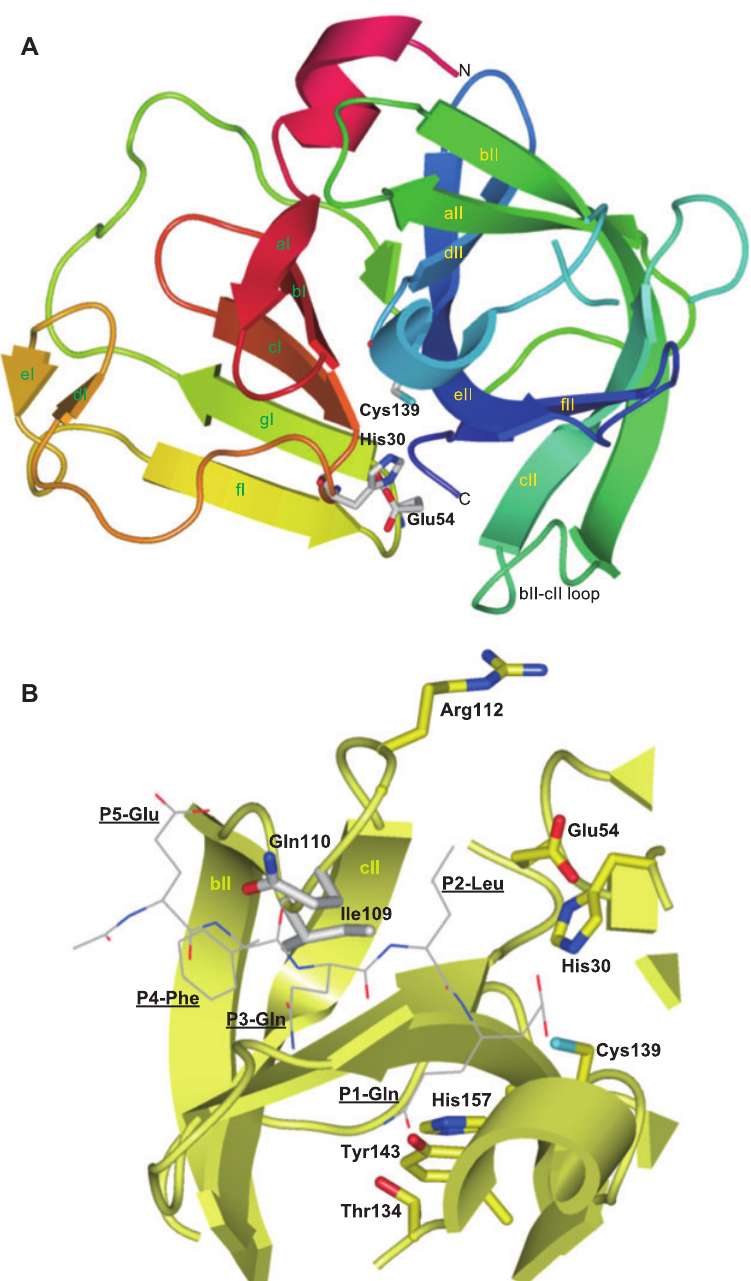
Figure 2 Crystal structure of the 3C-like protease from the norovirus Chiba strain. (A) Overall structure (PDB ID 1WQS). A catalytic triad, Cys139-His30-Glu54, in the active site is situated in a cleft between the N- and C-terminal domains. Side chains of these three residues are represented as sticks. The names for each β -sheet are indicated. The bII-cII loop stands for a loop region connecting the bII and cII β -sheets. (B) Model of inhibitor binding. A peptide inhibitor that was included in the crystal structure of the Southampton protease (PDB ID 2IPH) was incorporated into the active site of the Chiba protease using Waals software (Altif Laboratories, Tokyo, Japan). The inhibitor is represented as a wire frame. His157, along with Thr134 and Tyr143, is involved in recognition of the side chain at the P1 position. Ile109, Gln110, and Arg112 are located in the bII-cII loop and were targets of mutagenesis as described in the main text. Ile109 is likely to affect the recognition of both P2 and P4 residues.